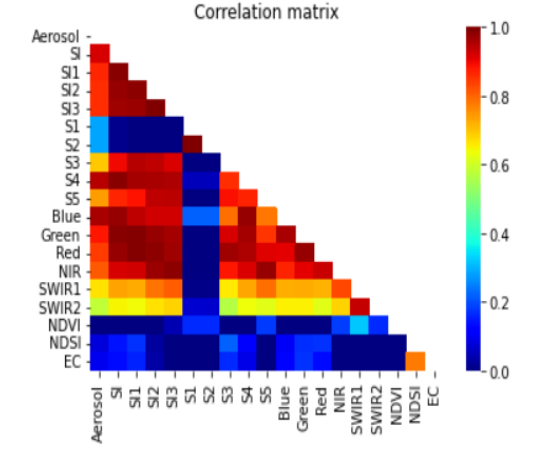
Figure 5 . Correlation between environmental features and the relation of environmental indices and electrical conductivity.